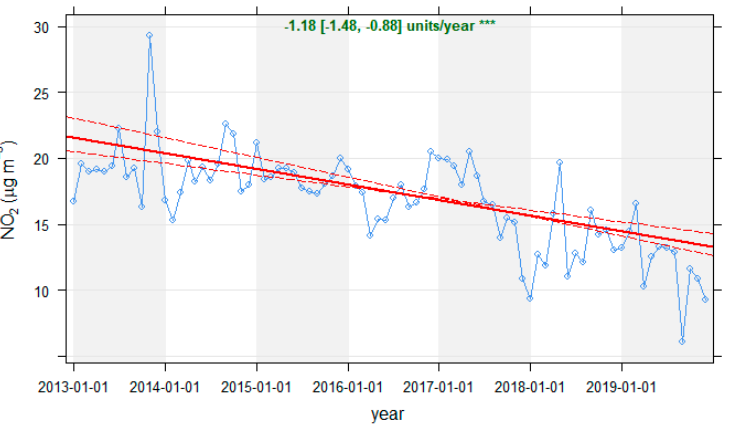
Figure 4. Trend analysis for NO 2 concentrations from 2013 to 2019 at the Zapatón site, using the “TheilSen” function. Overlaid is shown the slope with the 95% confidence intervals ( p -value < 0.005).